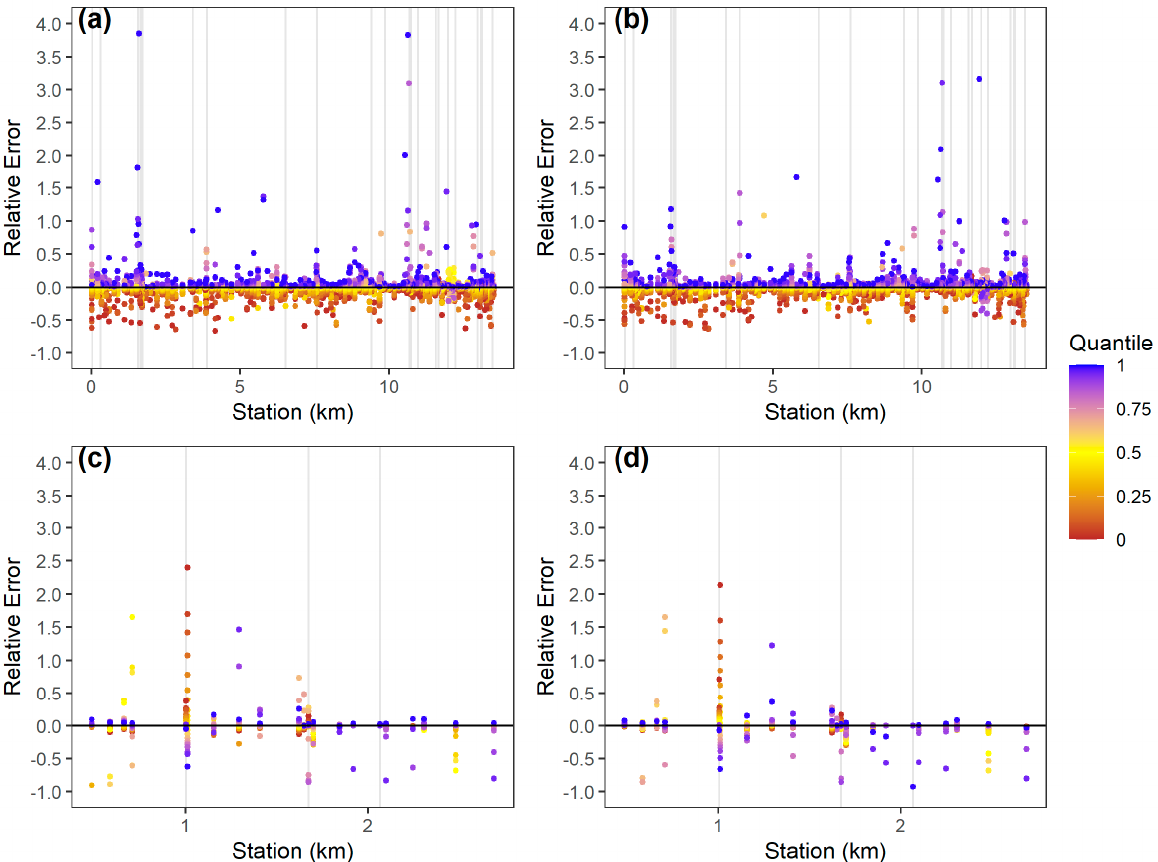
Figure 6. Inundated top width relative errors in SUB relative to MCS for ( a ) the 1% AEP flood at Proctor Creek, ( b ) the 2% AEP flood at Proctor Creek, ( c ) the 1% AEP probability flood at Bronx Wash, and ( d ) the 2% AEP flood at Bronx Wash. Vertical gray lines indicate hydraulic structure locations.